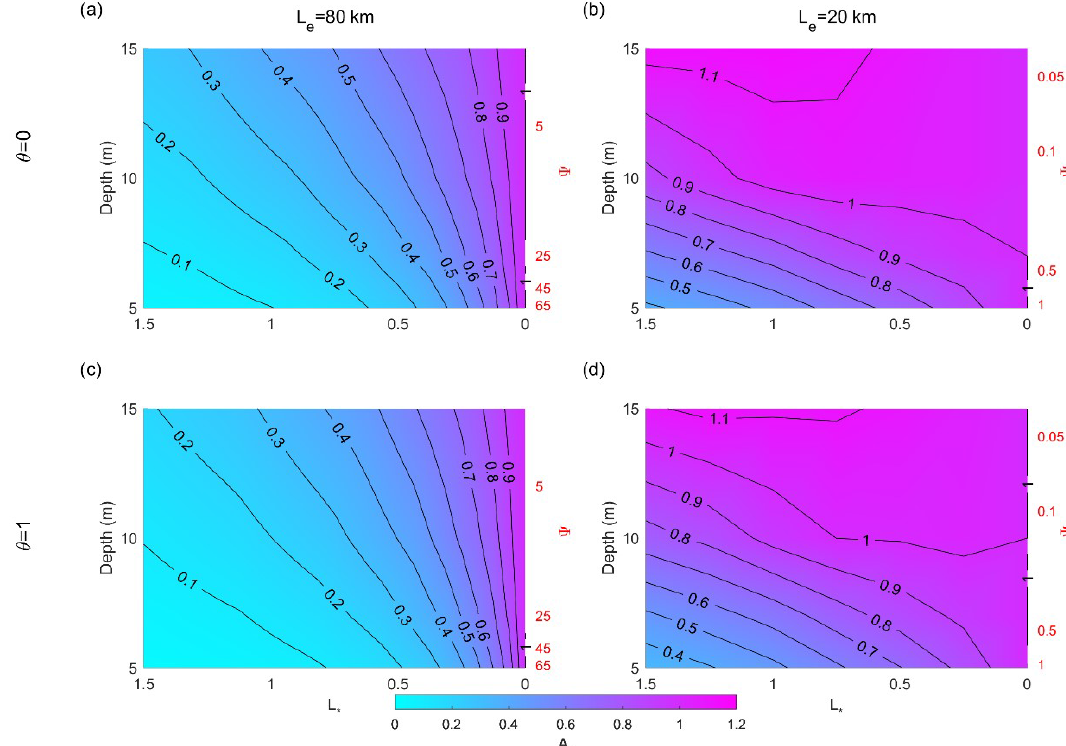
Figure 9. The effects of convergence length scale and river discharge on primary surge (12h, (cid:127) = 1) amplitude ( A ∗ is normalized amplitude) along a weakly convergent estuary, L e = 80km (subplots a, c ) and strongly convergent estuary, L e = 20km (subplots b, d ). The left-hand vertical axis is channel depth, the right-hand vertical axis is the corresponding nondimensional friction number horizontal axis represents the dimensionless coordinate system of L ∗ = x/L e